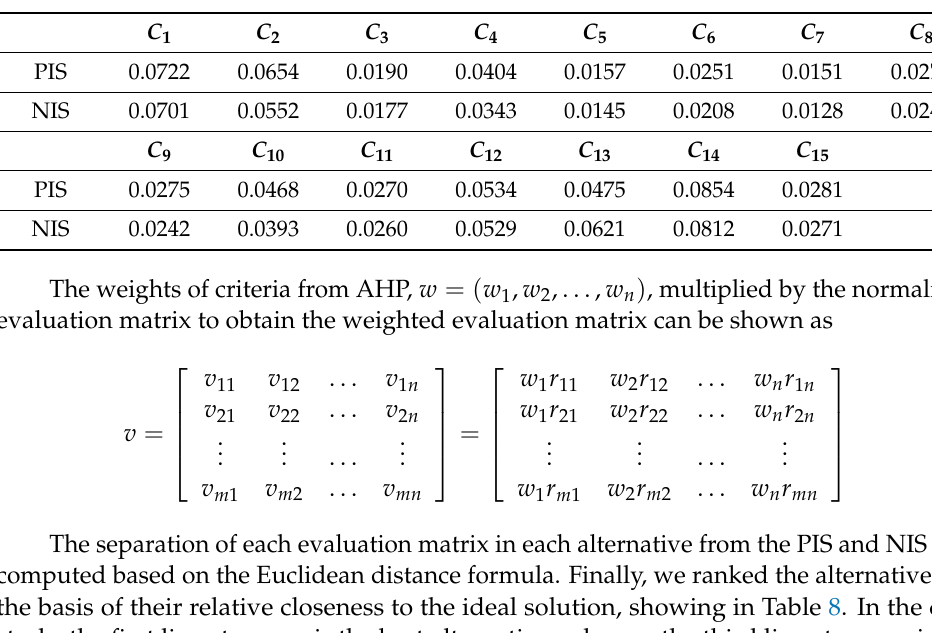
Table 7. PIS and